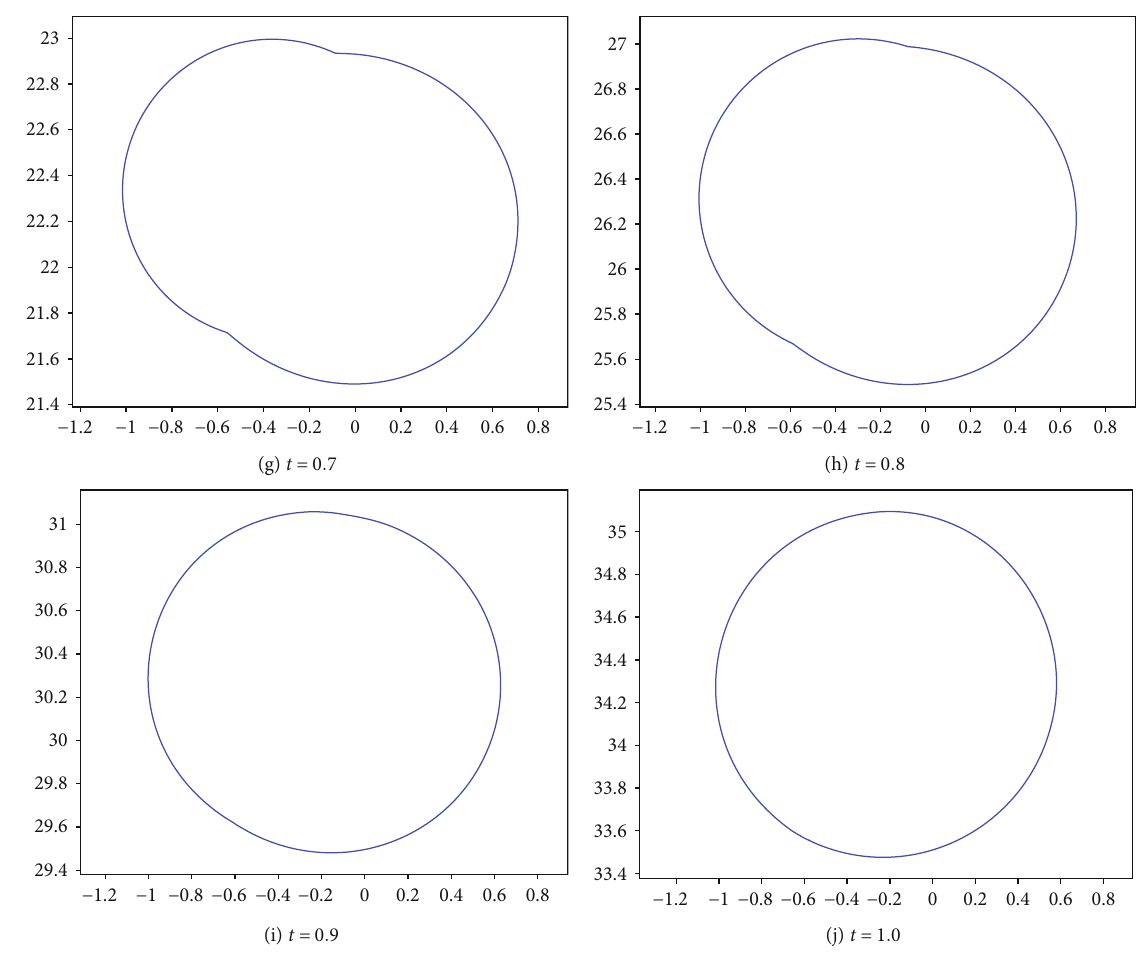
Figure 6: Coalescence of two 2D bubbles in nonhorizontal